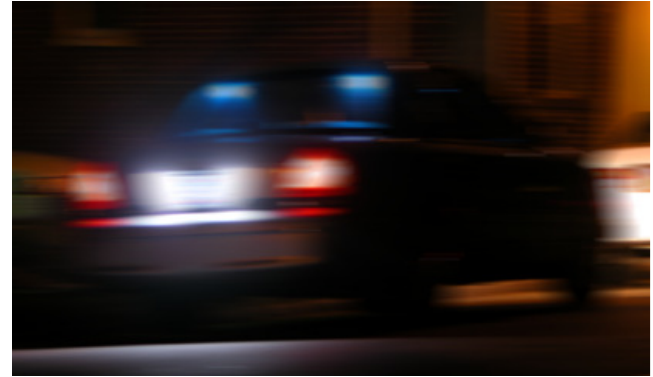
Figure 2. Motion blur